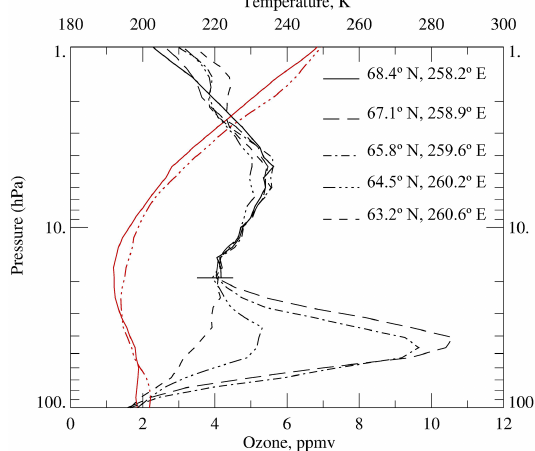
Figure 3. (in black) Five successive LIMS V6 ozone profile seg- ments along an orbital tangent path from 63 to 68 ◦ N and at 259 ± 1 ◦ E on 11 January 1979. The profile at 68.4 ◦ N, 258.2 ◦ E underwent a screening for contamination from effects of emissions from PSCs (below short horizontal line at the 19hPa level); (in red) temperature profile segments co-located with the two ozone profiles at 68.4 and 64.5 ◦